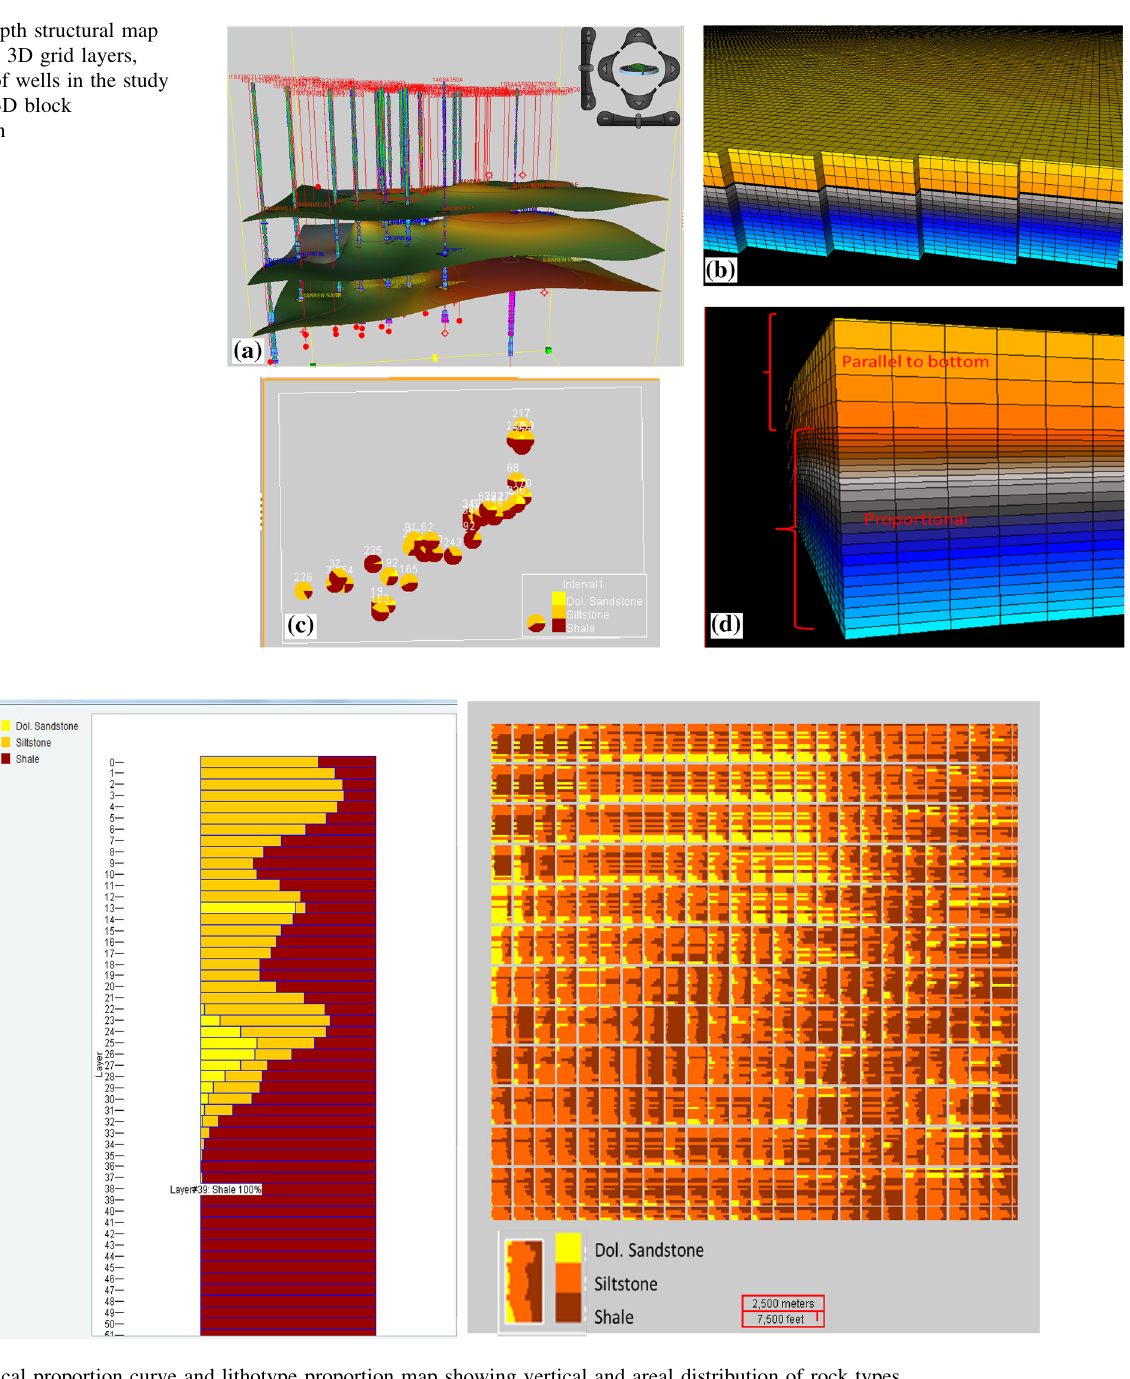
Fig. 5 Vertical proportion curve and lithotype proportion map showing vertical and areal distribution of rock